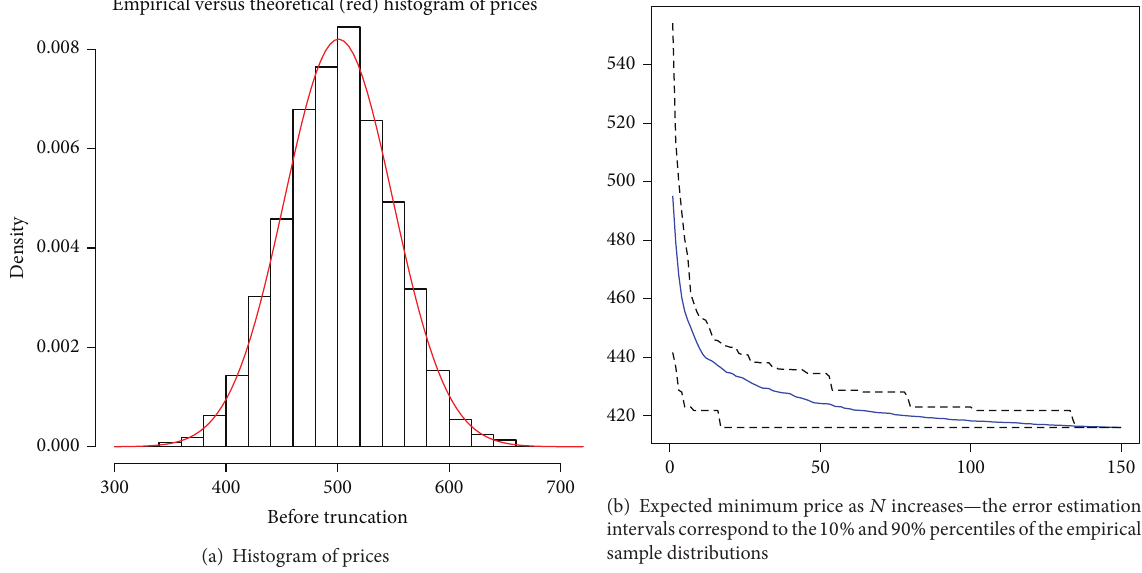
Figure 1: Price distribution and expected minimum prices, case of normal distribution 𝑁(500, 50) .